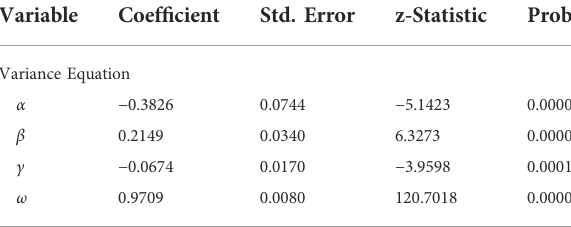
TABLE15EstimationresultsoftheEGARCH(1,1)modelofEUAfutures returns in phase II from 2 January 2008, to 31 December 2012. Variable